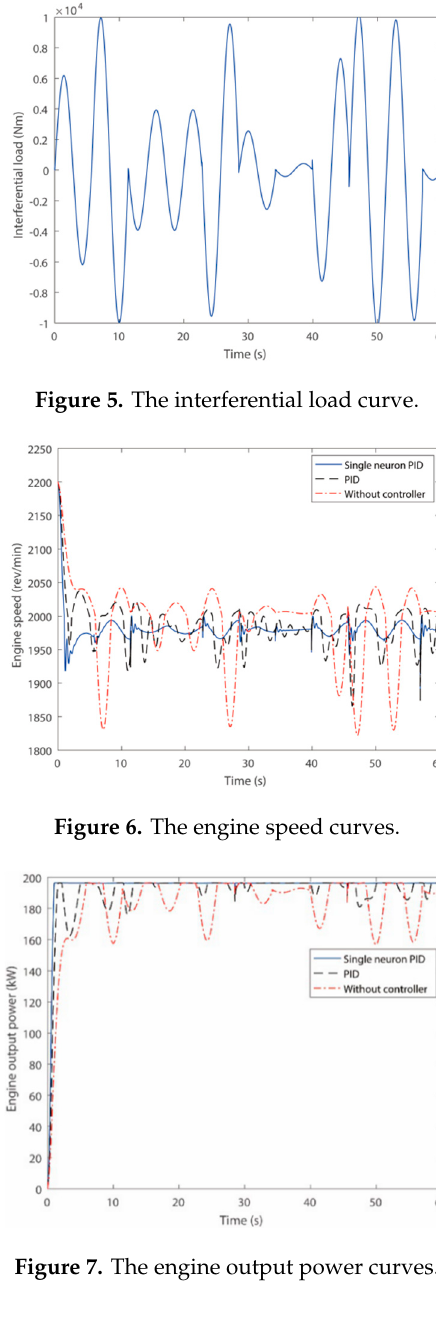
Figure 8. The machine work speed curves.